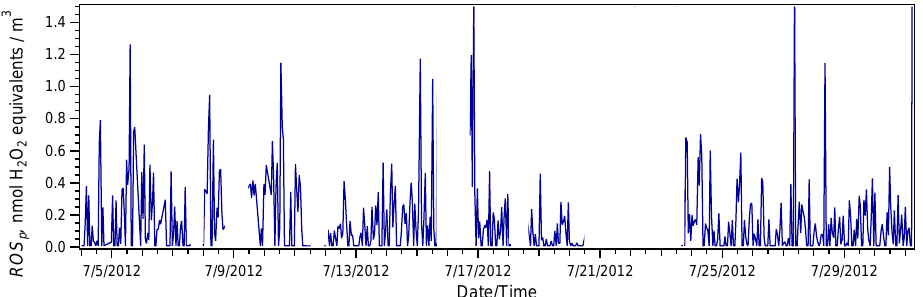
Fig. 9. Time series plot of ROS p at the Georgia Tech sites. ROS p below estimated limit of detection is plotted as 0.5 · (LOD).